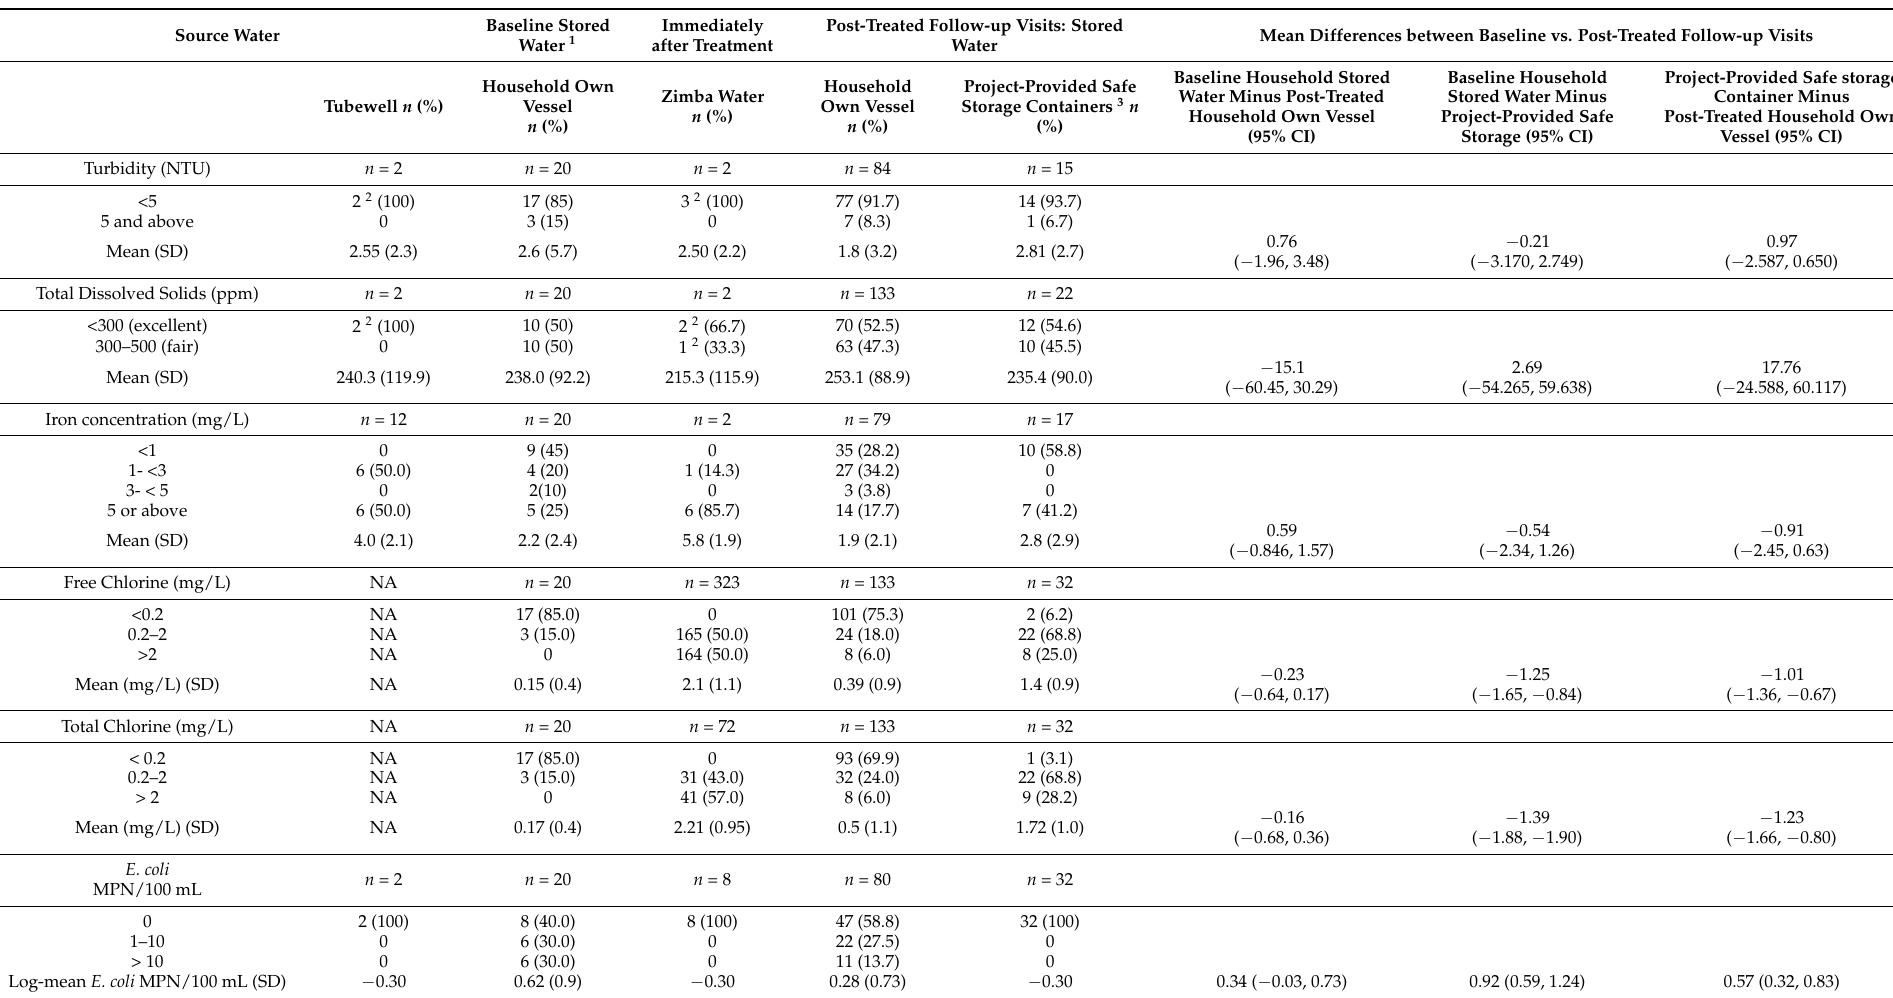
Table 2. Water chlorine residual and iron concentration among households during weekly follow up household visits in FDMN camp, Cox’s Bazar, 2018. Source